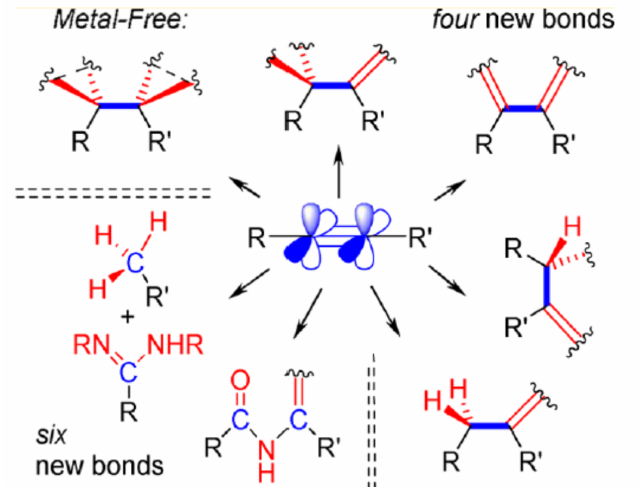
Figure 33. Using both alkyne π -bonds as “two functional groups in one package”. (Reproduced with permission from ref. [338]. Copyright 2013 American Chemical Society.).